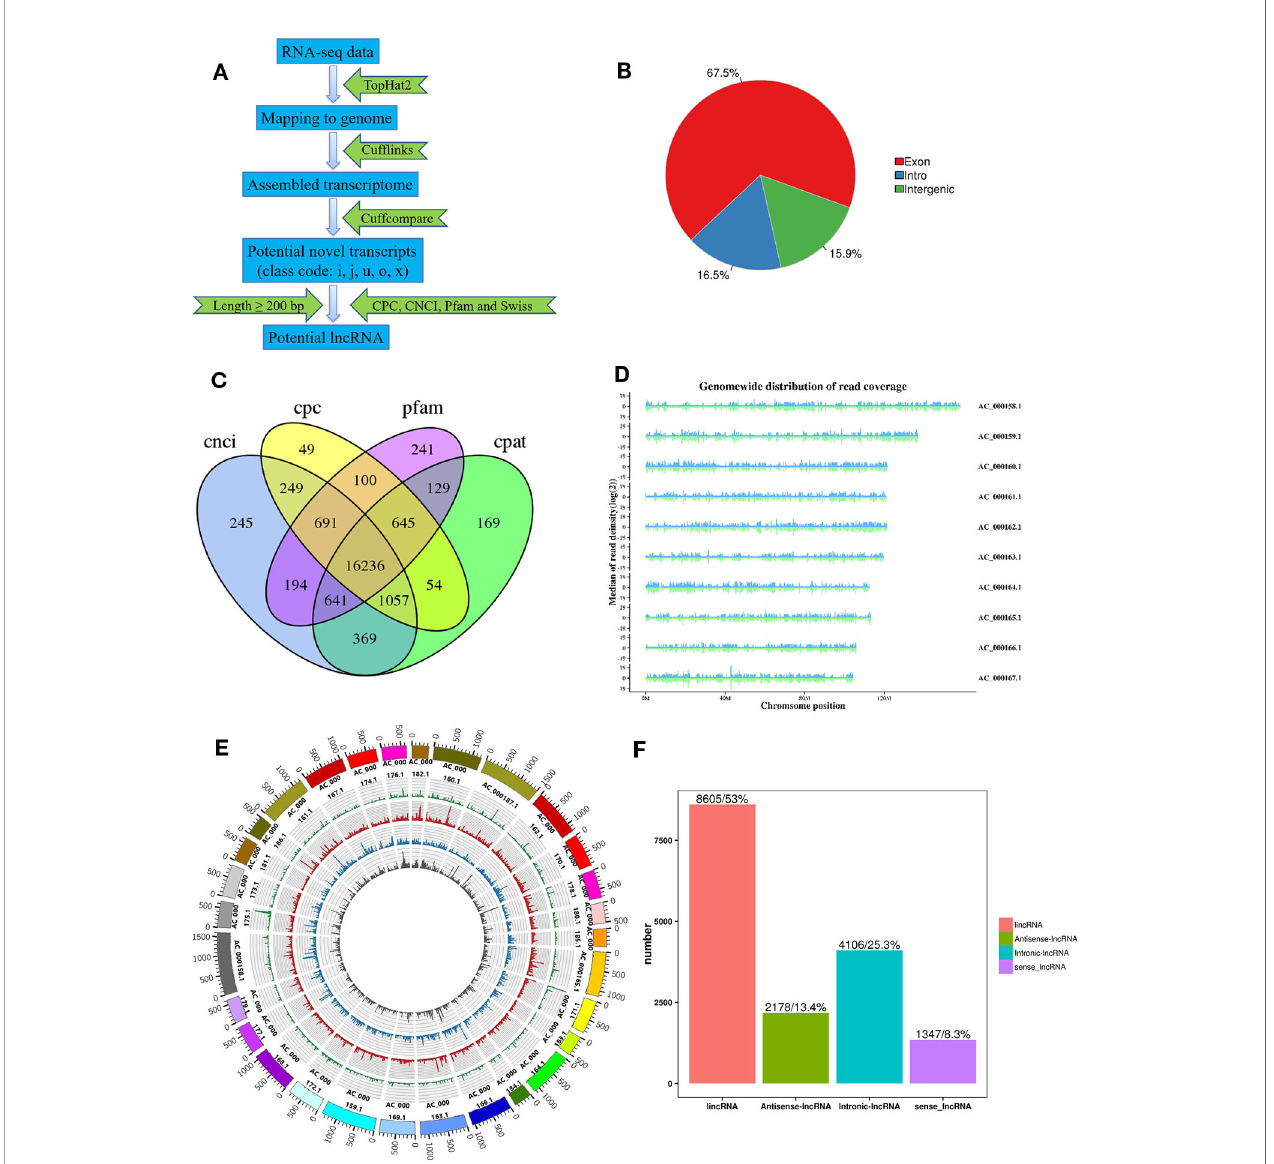
FIGURE 2 | Identi fi cation of lncRNAs in buffalo and cattle skeletal muscle tissue. (A) Work fl ow for the preparation and analysis of lncRNA libraries. (B) Pie charts representing the percentage of reads mapping to indicated genomic regions. (C) Venn diagram depicting the overlap of lncRNAs discovered in lncRNAs identi fi cation. (D , E) Distribution of lncRNAs along each chromosome. (F) Classi fi cation of lncRNAs, as de fi ned by their genomic location relative to neighboring or overlapping